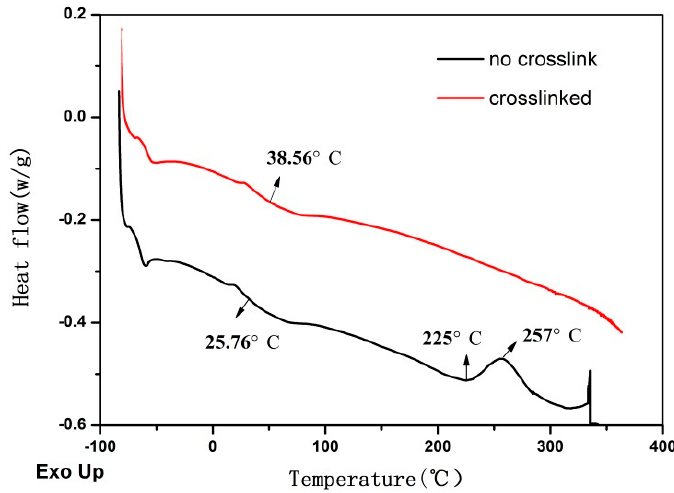
Figure 5. DSC curve of poly(IB- co -4-VBCB) containing 6 mol% 4-VBCB.